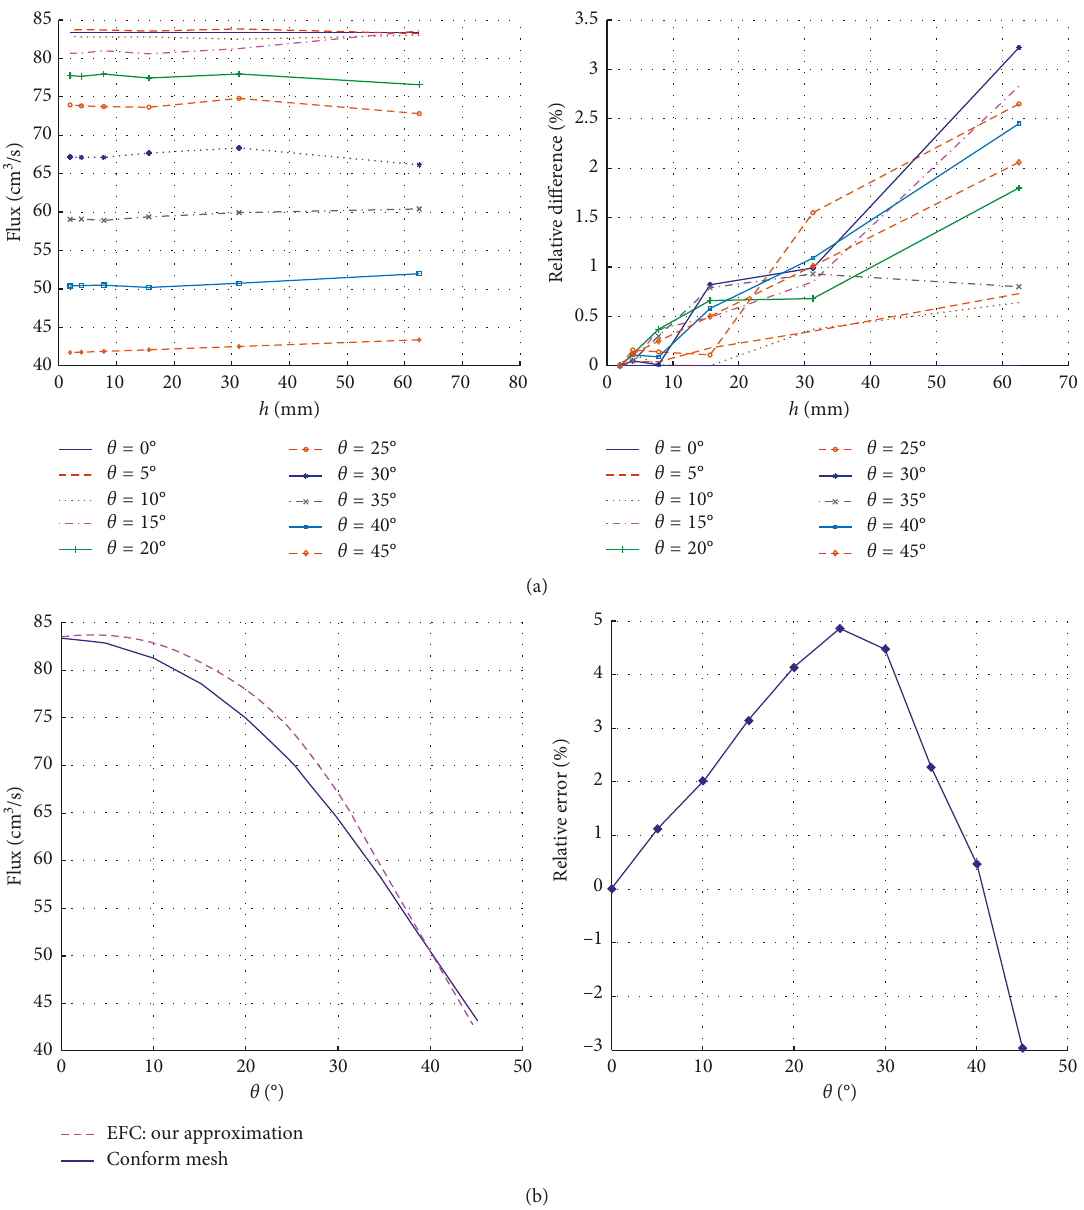
Figure 9: Horizontal flux going through the fractured medium and its convergence as function of the fracture cell size and inclination angle of fracture (a); comparison of the horizontal flux determined from the conformed mesh and nonuniform mesh models